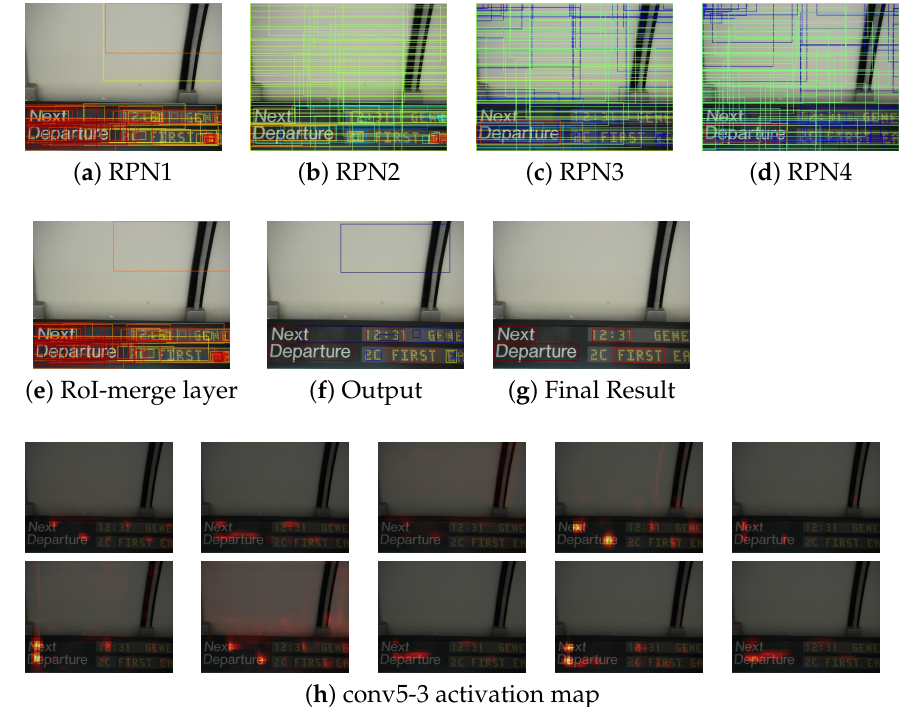
Figure 8. Failure examples 1. ( f ) classification results of the proposals. Red and blue represent text and background, respectively. Activation maps in ( h ) are resized to the input